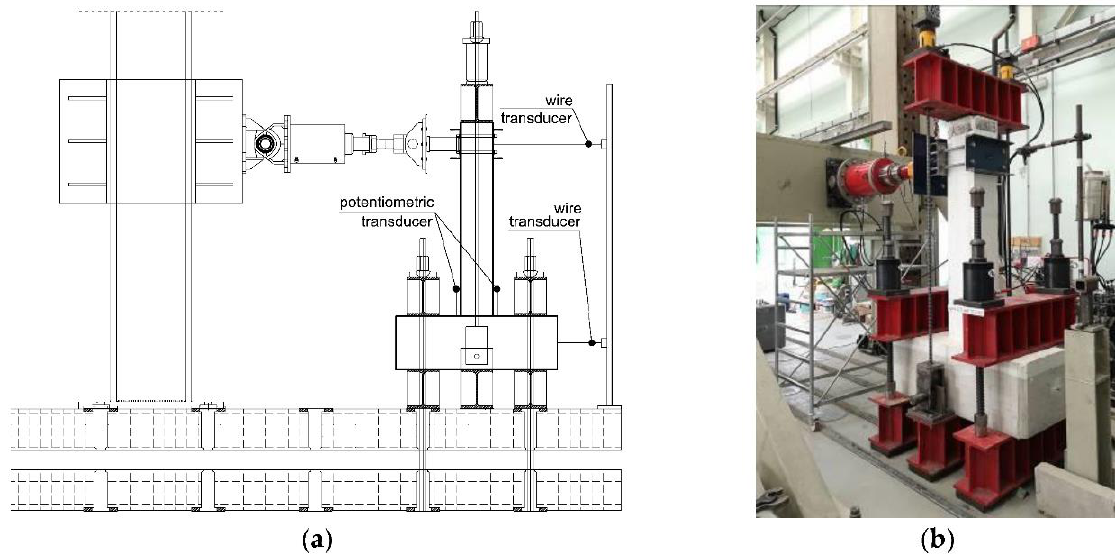
Figure 2. ( a ) Scheme of Test set-up; ( b ) test set-up.